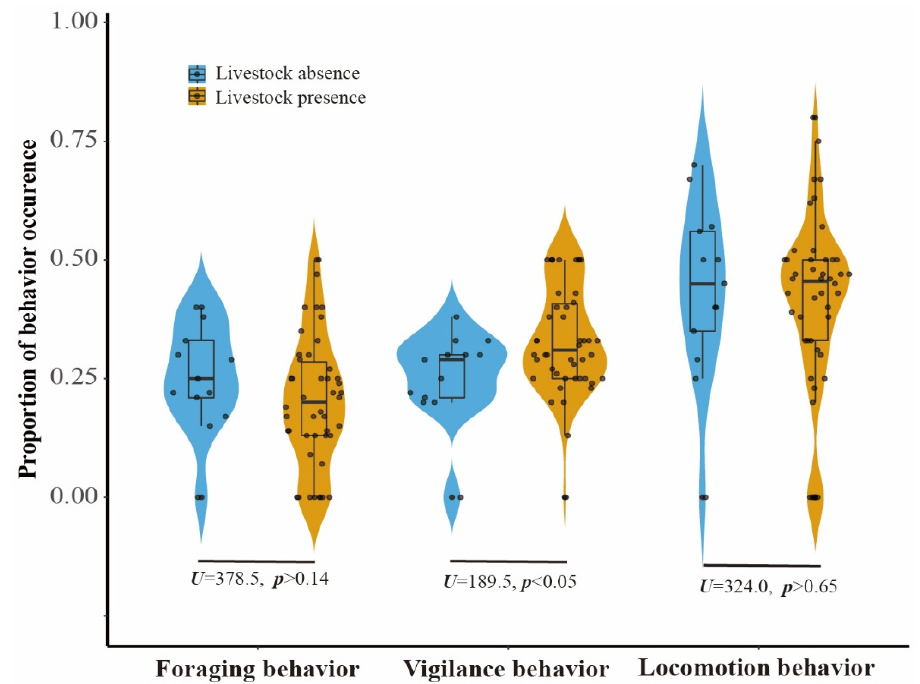
Figure 3. Proportion of Reeves’s Pheasant’s foraging, vigilance, and locomotion behaviour occurring at camera trap stations in the presence (yellow) and absence (blue) of livestock.